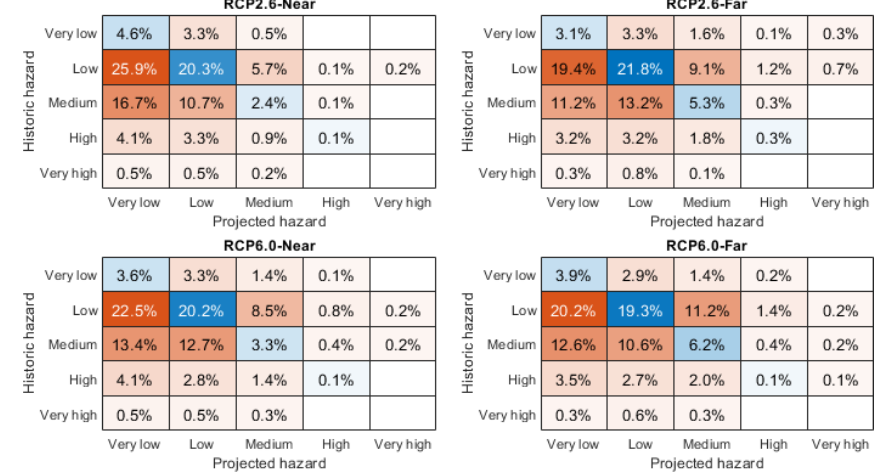
Figure 4. Transition of drought hazard from baseline period to projected period. The value in each cell represents the change in percent area of the country from one hazard class to another. The red colour shows transition, and blue represents no